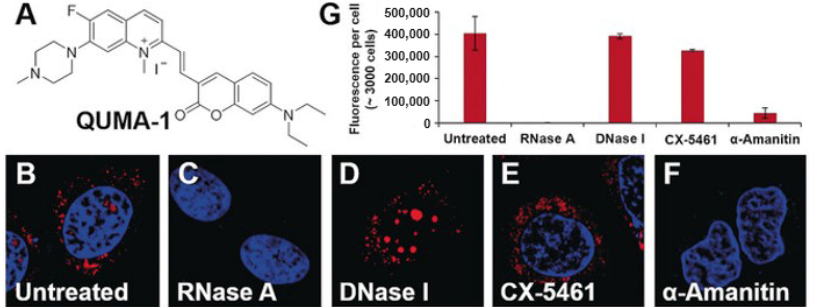
Figure 8. ( A ) Chemical structure of QUMA-1; confocal microscopy images of fixed HeLa cells ( B ) stained with QUMA-1; ( C ) stained with QUMA-1 and treated with RNase A; ( D ) stained with QUMA-1 and treated with DNase I; ( E ) stained with QUMA-1 and treated with CX-5461 and ( F ) stained with QUMA-1 and treated with α -Amanitin. ( G ) Fluorescence intensity per cell. Copyright (2018) Wiley. Adapted with permission from [116] Copyright 2018 John Wiley and Sons, Inc.